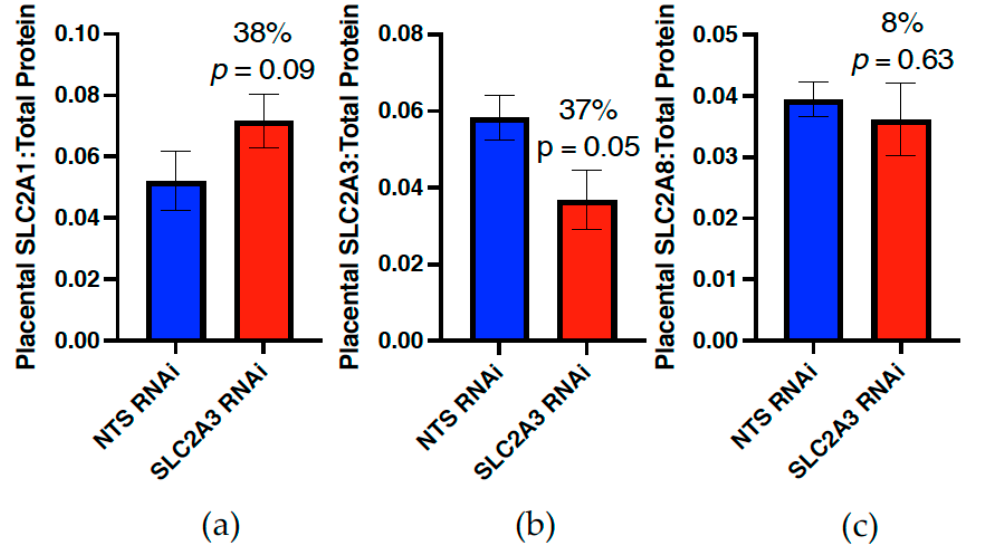
Figure 2. Impact of SLC2A3 RNAi on placental concentrations of ( a ) SLC2A1, ( b ) SLC2A3 and ( c ) SLC2A8 at mid-gestation in sheep. Data are shown as means ± SEM. NTS, non-targeting sequence; RNAi, RNA interference.